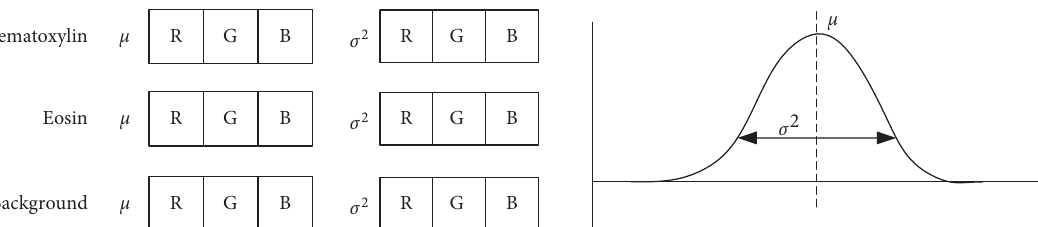
Figure 3: The stain intensity map of hematoxylin, eosin, and background channels is obtained from the histopathology image by the proposed stain separation framework.